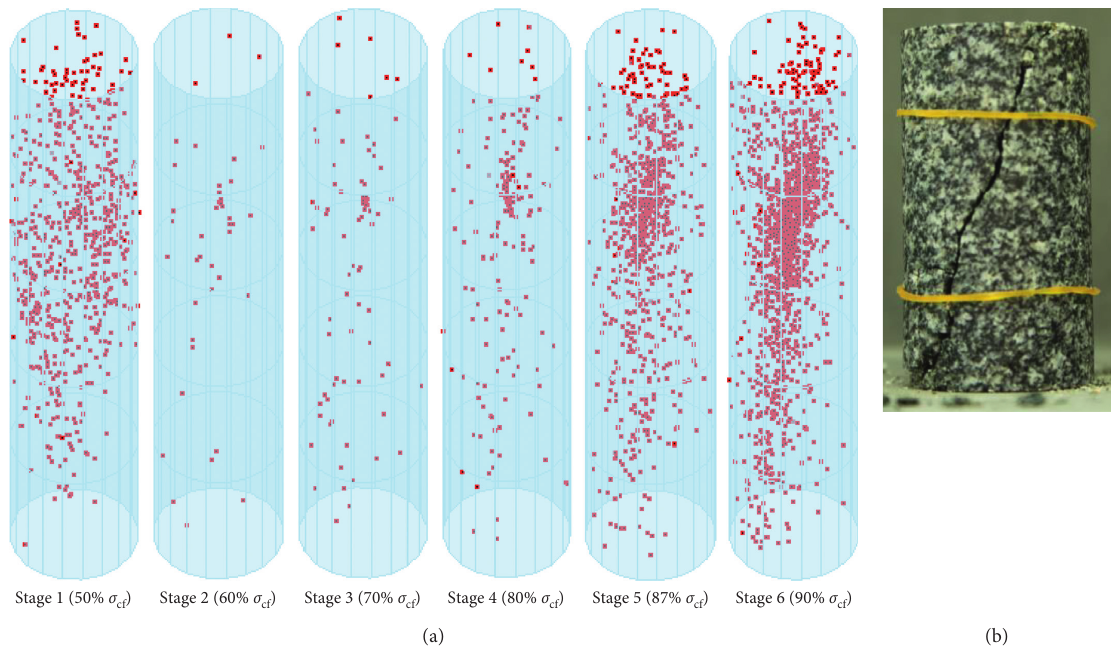
Figure 7: AE spatial distribution and failure pattern of loading-cracked specimen at high confinement (specimen L4, σ spatial distribution at different creep stages. (b) Failure